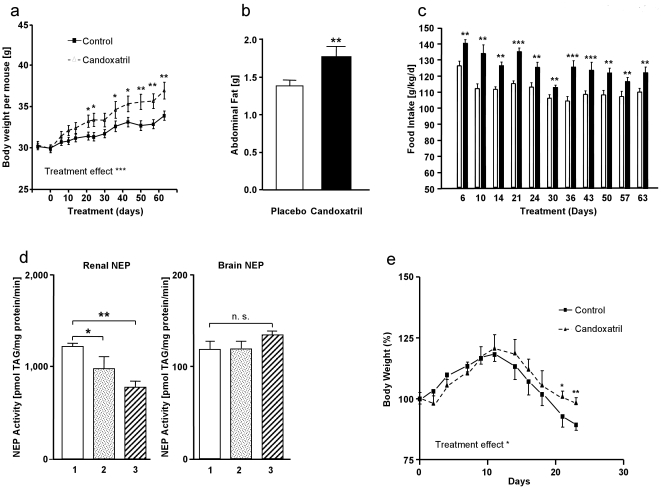
Effects of candoxatril (Pfizer, UK79,300) on body mass development.(a) Development of body weight in male C57BL/6 mice starting in an age of 6 months fed with standard diet, supplemented with placebo (solid line and squares) or of the NEP inhibitor candoxatril [consumption 200 mg/kg/day] (broken line and triangles). Treatment day 0 is the first day of treatment. Treatment effect ***P<0.001 by two-way ANOVA. Significant differences at specific time-points are calculated by Bonferroni post-hoc test, *P<0.05 and **P<0.01. (b) Abdominal fat in male C57BL/6 mice after feeding with standard food (open column) or with food supplemented with the NEP inhibitor candoxatril (black column) for two months [consumption 200 mg/kg/day]. Student's t-test **P<0.01 versus placebo. (c) Development of food intake in male C57BL/6 mice fed with standard food (open columns) or the same food supplemented with the NEP inhibitor candoxatril (black columns) [consumption 200 mg/kg/day]. Student's t-test **P<0.01, ***P<0.001 versus placebo. (d) Development of NEP activity in kidney (left panel) and brain (right panel) of mice after oral treatment with candoxatril (1) Placebo, (2) 100 mg/kg/day candoxatril, (3) 200 mg/kg/day candoxatril. Student's t-test *P<0.05, **P<0.01 versus placebo. (e) Development of body weight in male tumor-bearing mice (Pancreas carcinoma, PSN-1) fed with standard food (solid line and squares) or standard food supplemented with the NEP inhibitor candoxatril (200 mg/kg/day, broken line and triangles). Treatment effect *P<0.05, by two-way ANOVA. Significant differences at specific time-points are calculated by Bonferroni post-hoc test, *P<0.05 and **P<0.01.